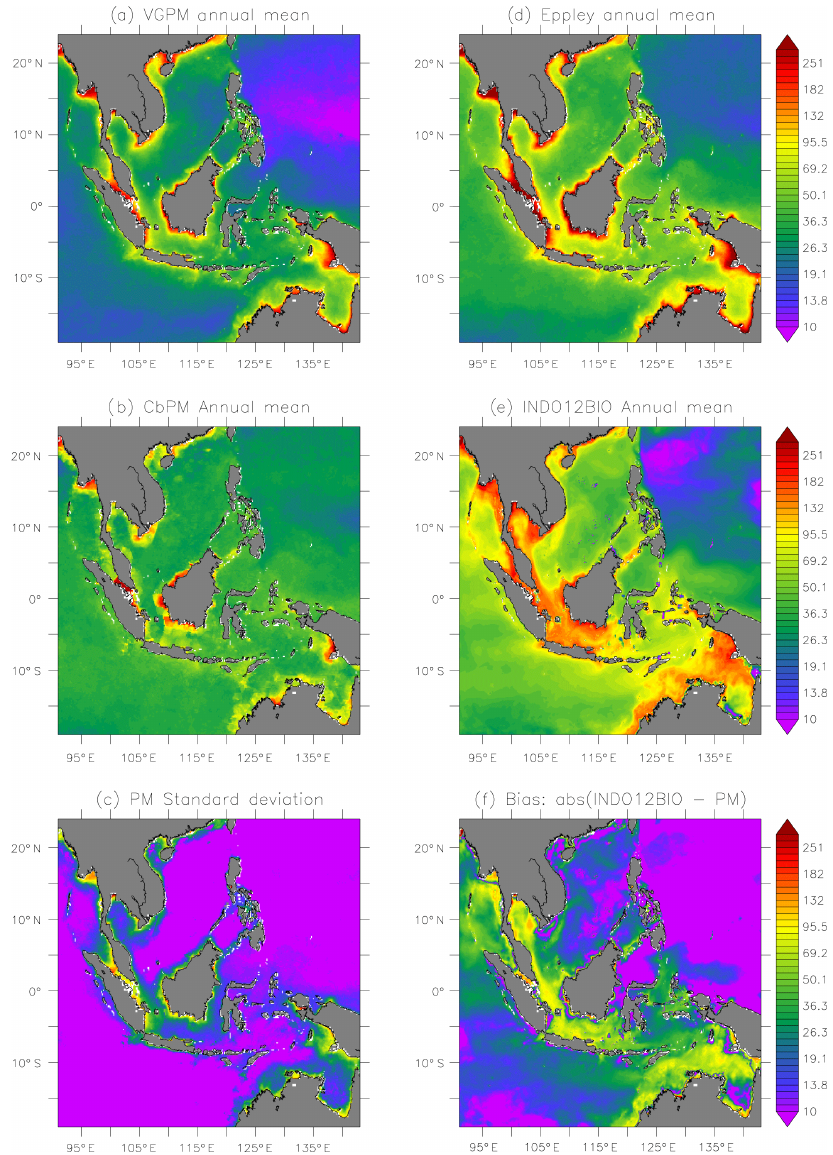
Figure 5. Annual mean of vertically integrated NPP (mmolCm − 2 d − 1 ) for year 2011: VGPM (a) , Eppley (d) and CbPM (b) production models, all based on MODIS ocean colour, as well as for INDO12BIO (e) . Standard deviation of the three averaged production models (PM) (c) , and bias between INDO12BIO and the average of PM (f)